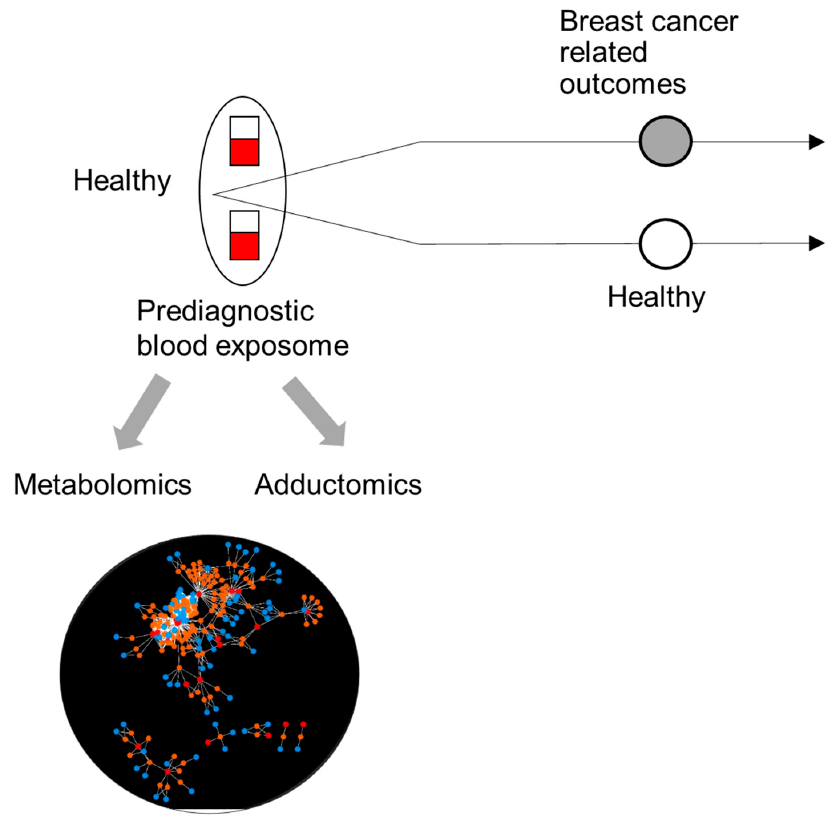
Figure 1. Conceptual diagram. Exposome-wide association studies using a prospective case-control design can discover novel environmental risk factors related to breast cancer. The exposome includes measurements of a rich set of molecular information in prediagnostic biospecimens. Cases can be breast cancer cases or cases with phenotypic measures related to breast cancer.